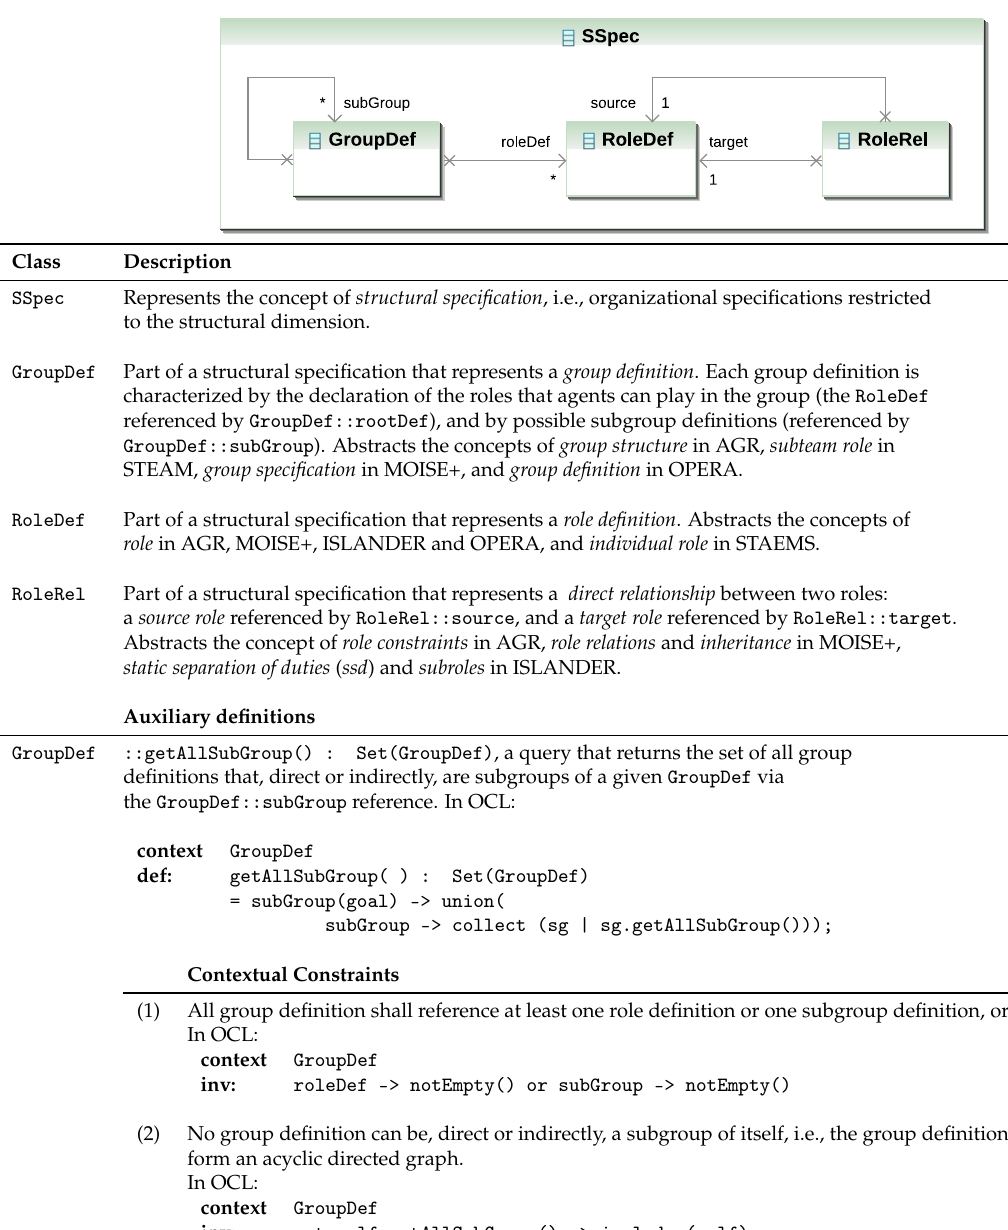
Table 4. Structural specification